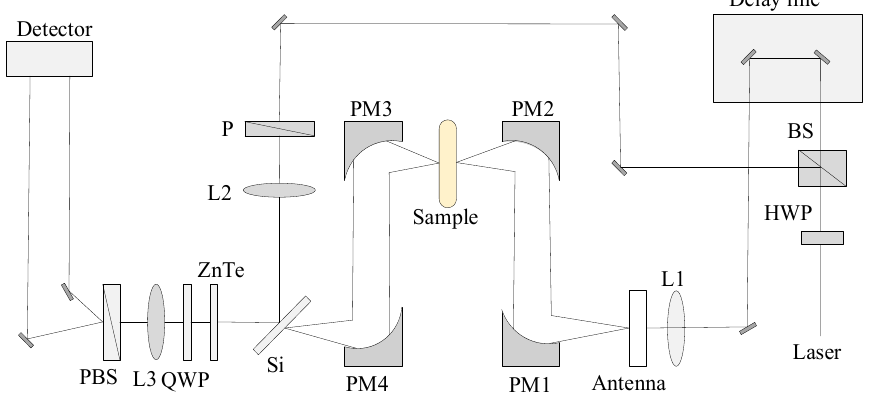
Figure 3. Schematic diagram of THz device.